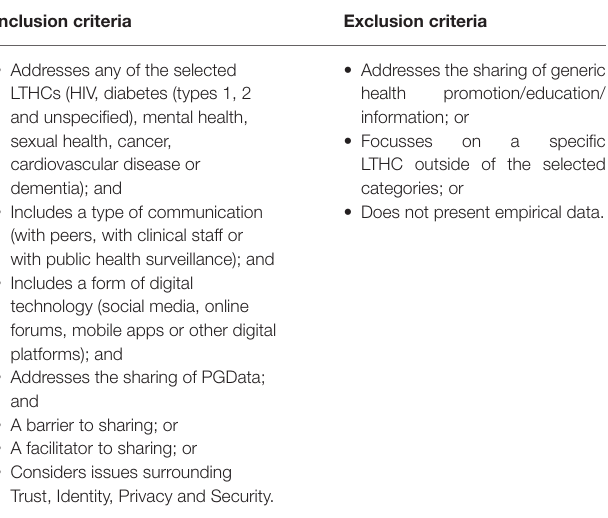
TABLE 1 | Inclusion and exclusion criteria for selecting peer-reviewed articles. Inclusion criteria Exclusion